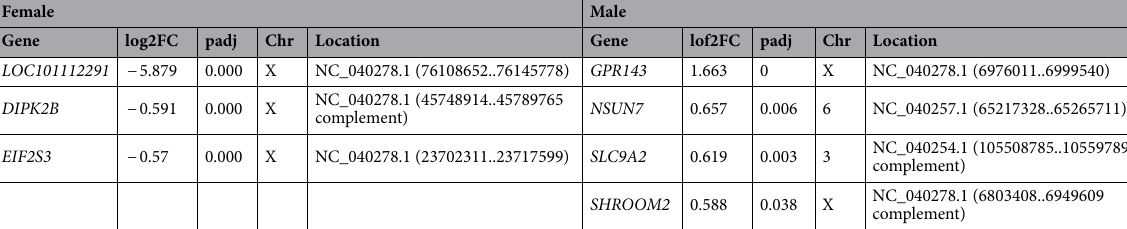
Table 1. Top differentially expressed coding RNA between the control female and control male fetal LV tissue. Genes in either the female or male control sheep enriched at adjusted-p value (padj) < 0.05 and absolute log2 fold change (log2FC) > 0.5 are represented. Genes highly expressed in the female fetal LV tissue are represented as negative values and those highly expressed in the male fetal LV tissue are represented as positive values. ncRNA is highlighted in grey.